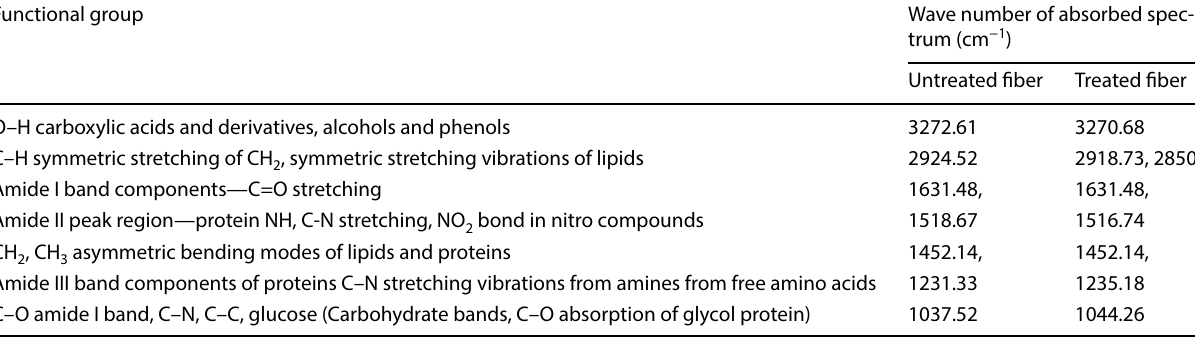
Table 3 FTIR spectrum and its characteristics of untreated and treated human hair Functional